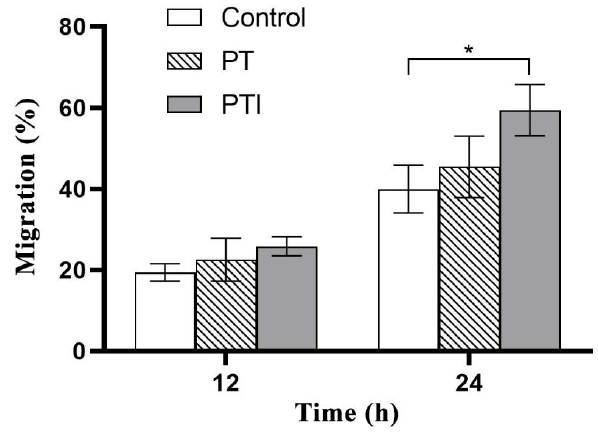
Figure 8. Quantitative analysis of cell scratching experiment. * p < 0.05.